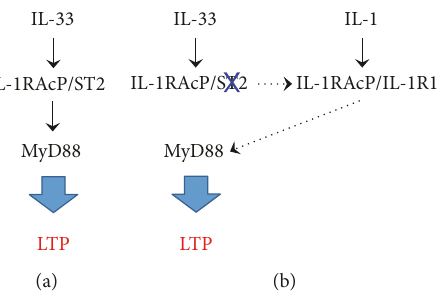
Figure 4: Plausible pathways for IL-33-induced LTP in the presence (a) and absence (b) of